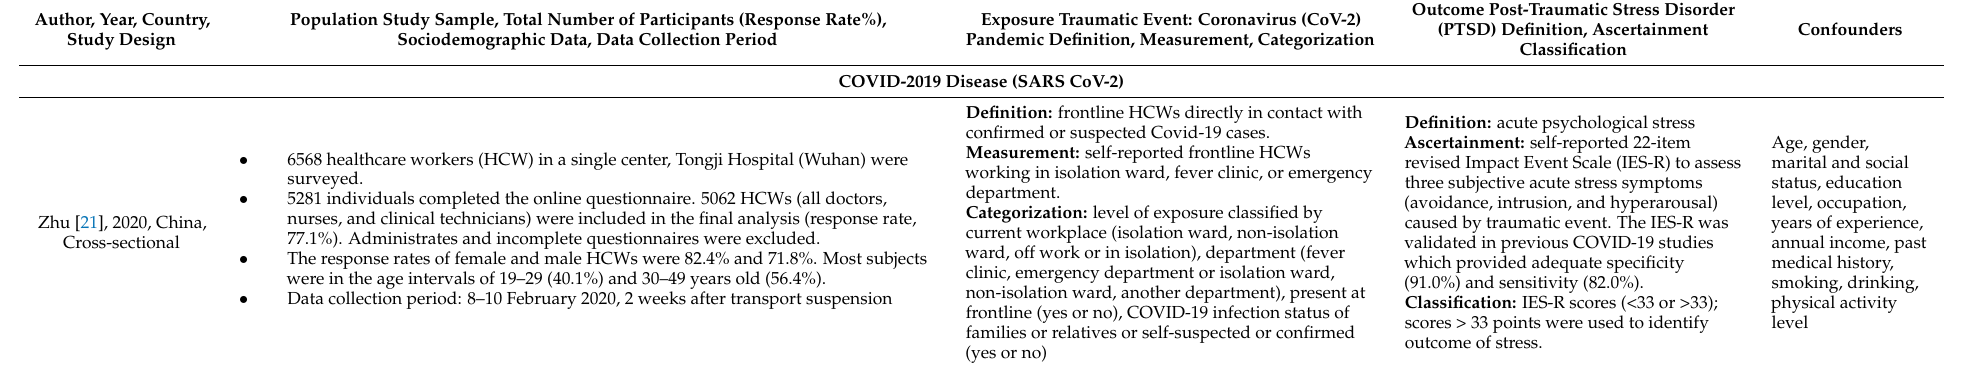
Table 1. Characteristics of COVID-2019 disease (severe acute respiratory distress syndrome (SARS) CoV-2) studies (population, exposure, outcomes, and confounders). USA, United States of America; PPE, personal protective